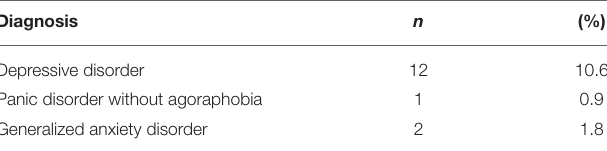
TABLE 3 | Prevalence of depressive and anxiety